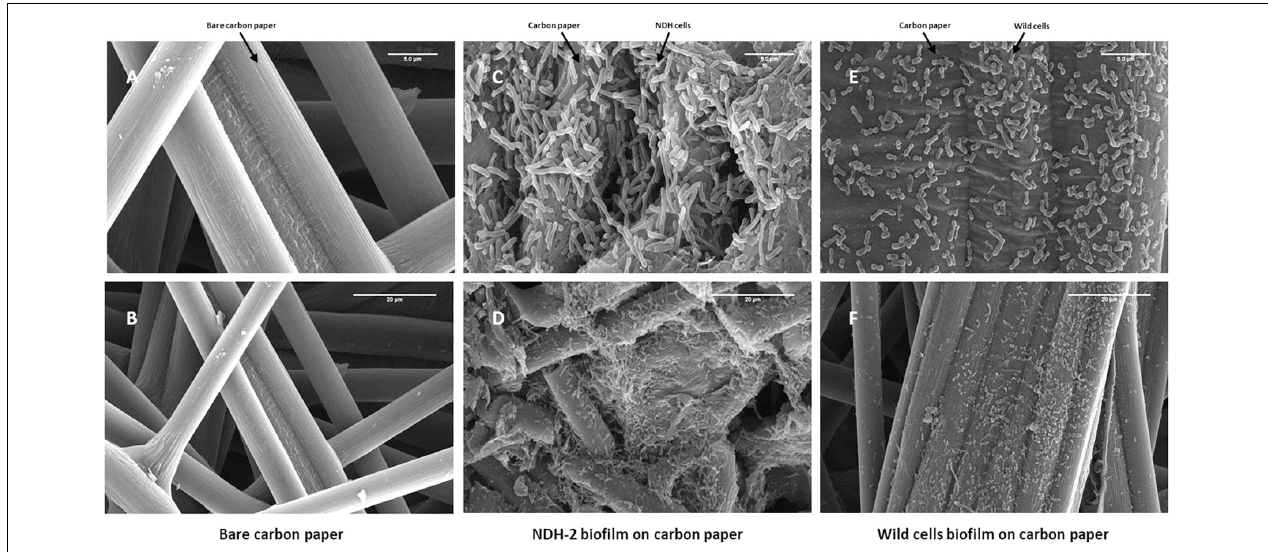
FIGURE 8 | Biofilm formation on the FTO plates after chronoamperometry. Biofilm was captured by using FE-SEM at 20 kV. After seven cycles of applied potential, it was observed that the cell density was more on the NDH-2 BES anode. (A) Bare carbon paper at 5 µ m scale, (B) Bare carbon paper at 20 µ m scale, (C) NDH-2